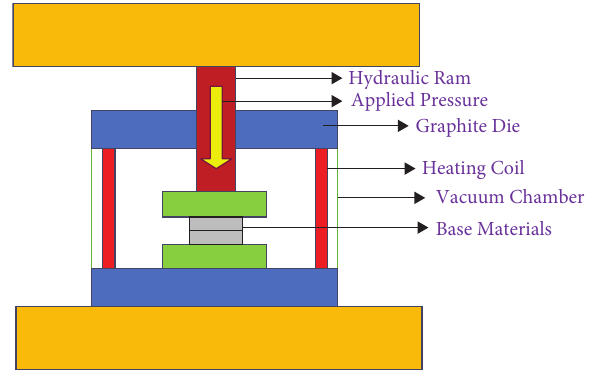
Figure 2: Schematic diagram of the diffusion bonding machine.